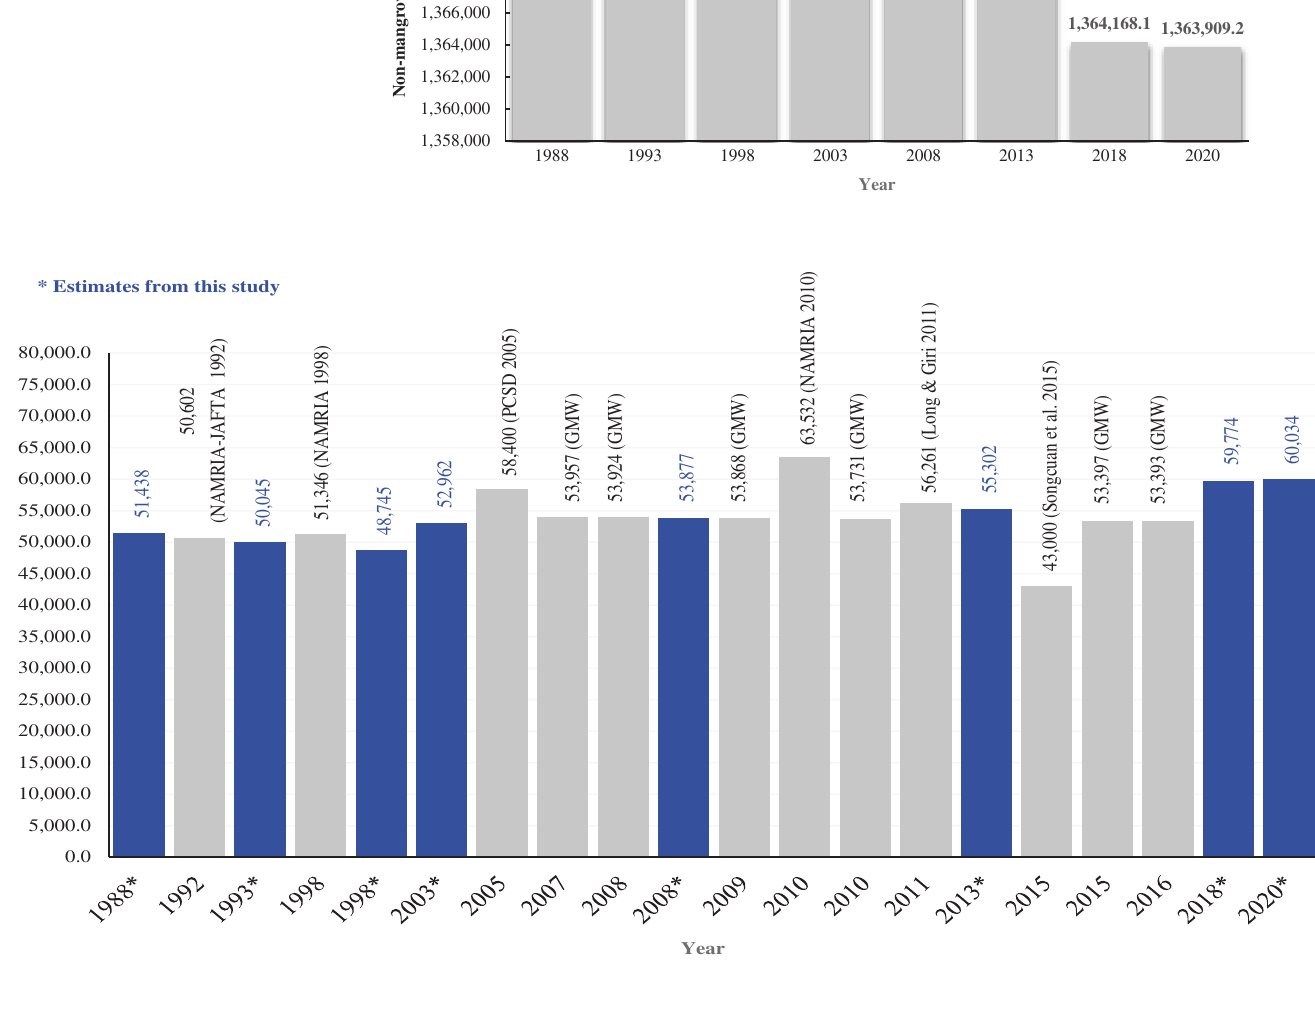
Estimated total cover of non-mangrove areas in Palawan from 1988 to